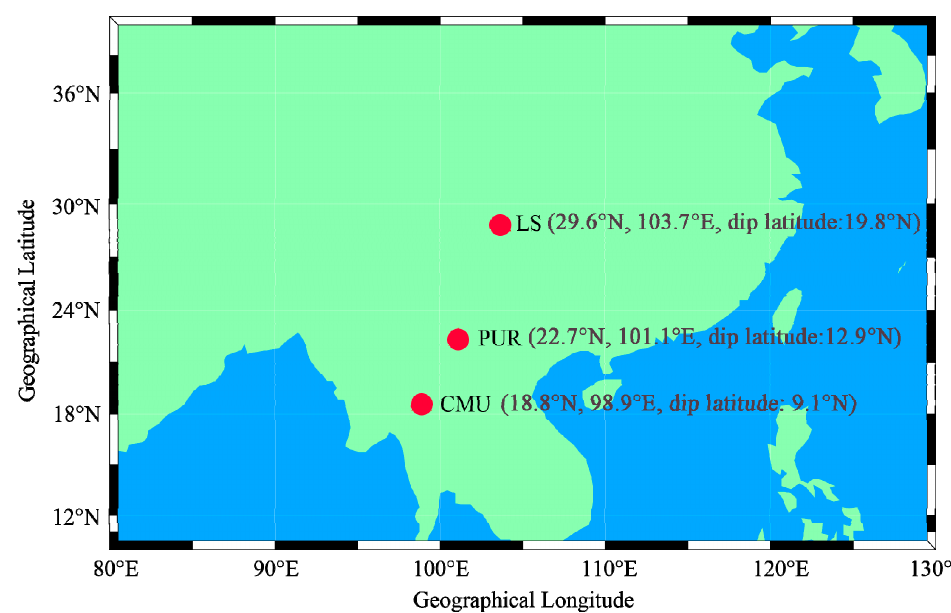
Figure 1. The positions of three ionosondes at equatorial ionization anomaly (EIA) crest around 100° E longitudinal sector.